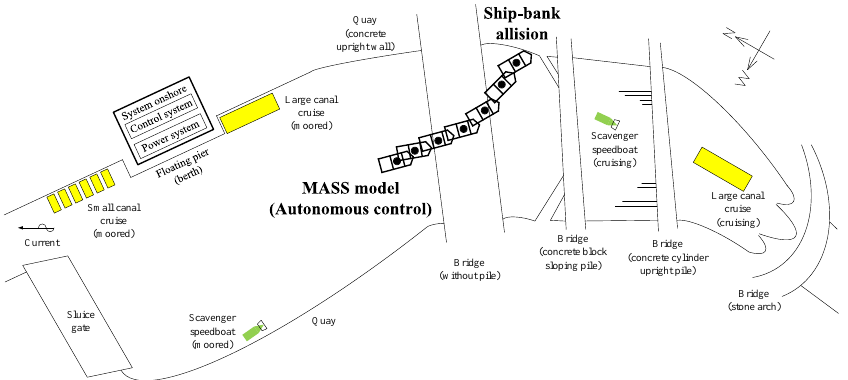
Figure 1. A potential accident of the model MASS trial in Qinhuai River (Source: The first author).